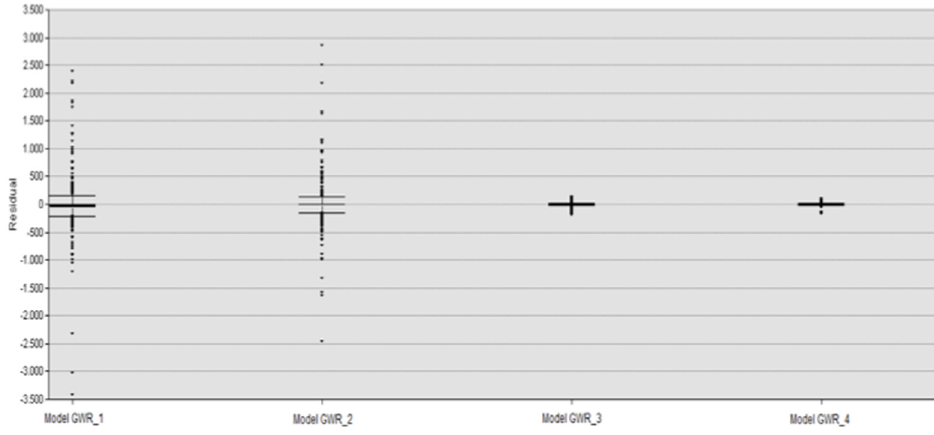
Figure A4. Distribution of errors for each GWR Model.